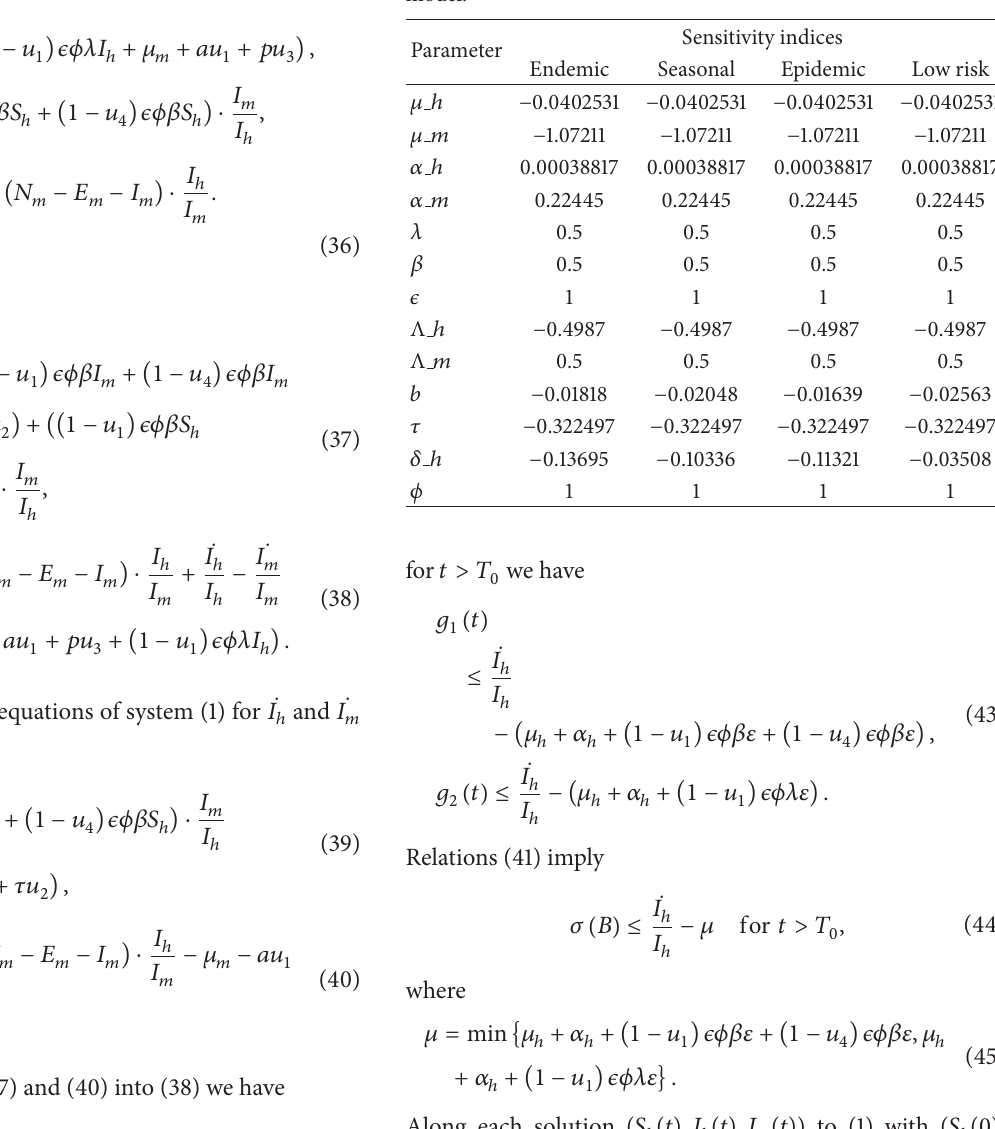
Table 4: Sensitivity indices (SI) of 𝑅 0 to parameters for the malaria